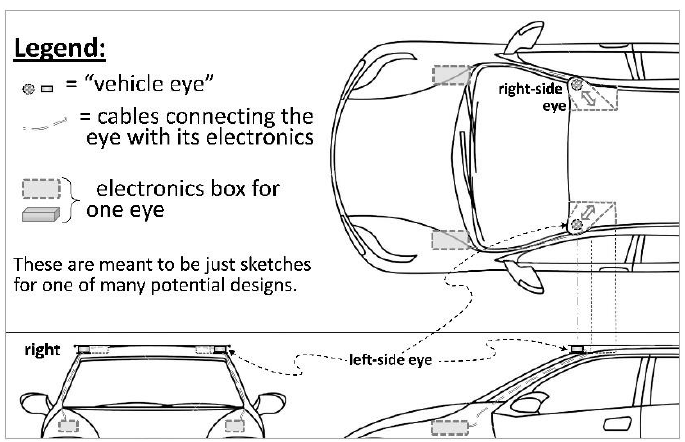
Figure 20. One potential design of the upper end of the A-frame for a standard solution for mounting front eyes.